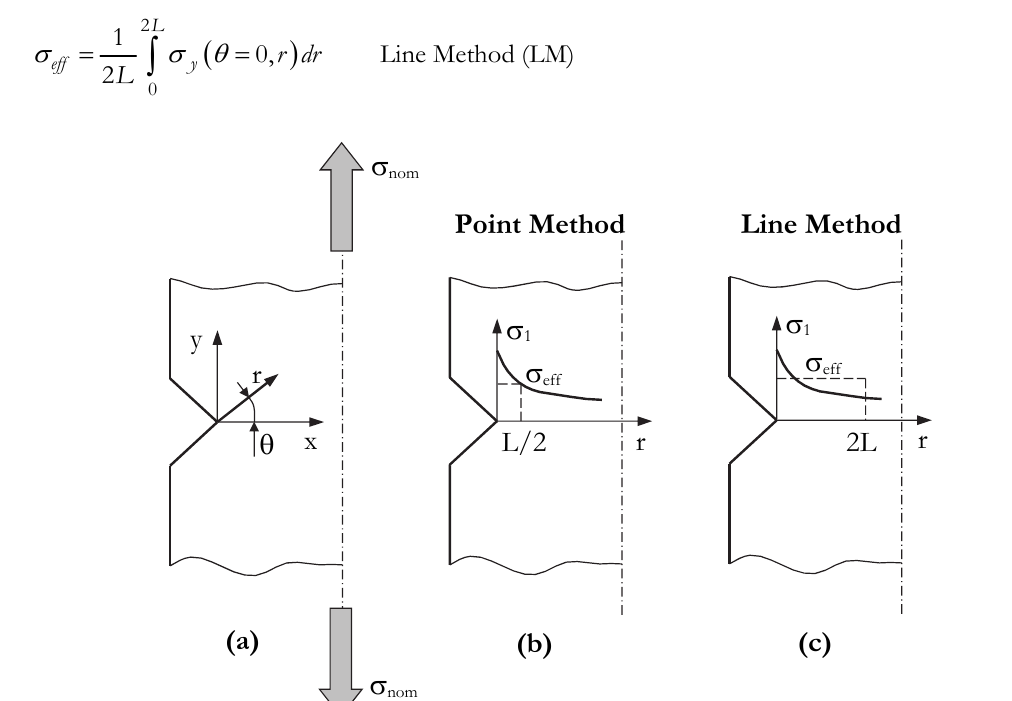
Figure 1: Definition of the local systems of coordinates (a) and effective stress,  eff , calculated according to the Point Method (b) and the Line Method (c).